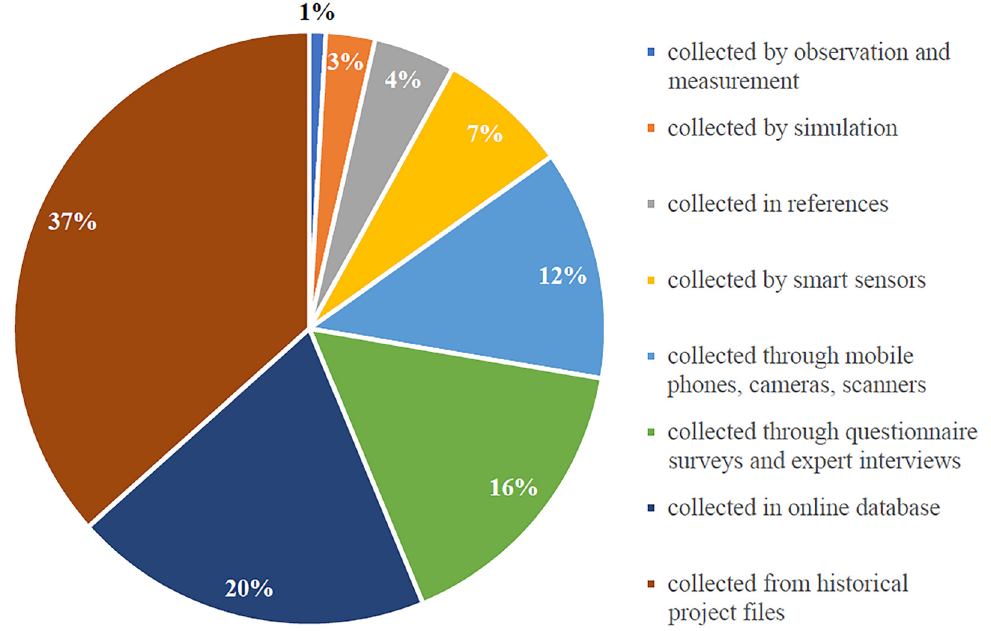
Figure 8. Methods of data collection of ANN application in CM.